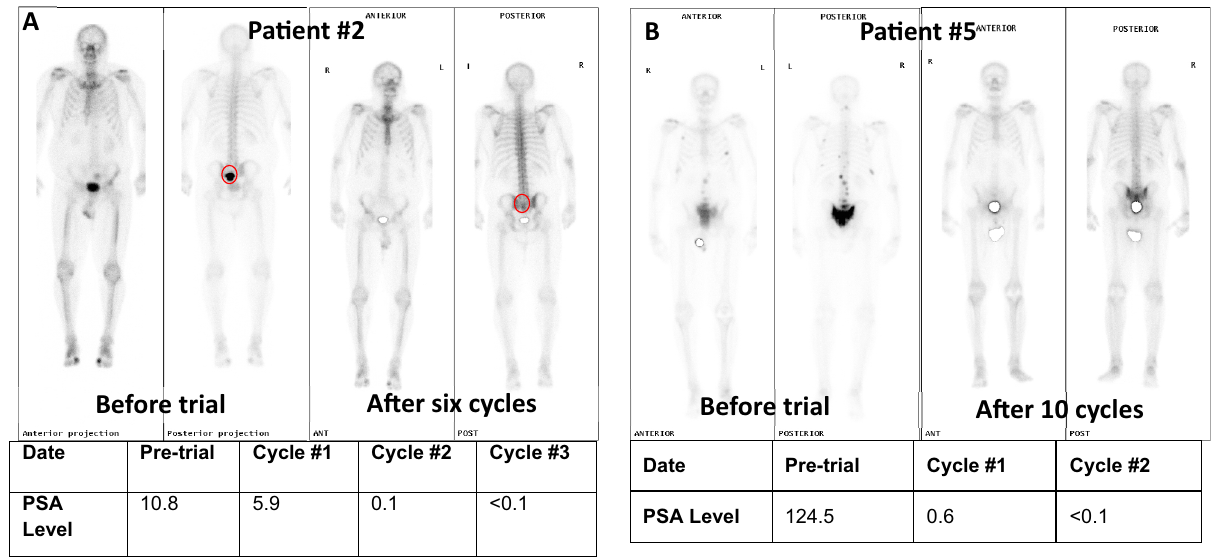
Figure 1. Bone scans and PSA kinetics in two patients with complete PSA response. In both patients, PSA became undetectable after three cycles in the combination treatment. The time of bone scan was indicated in the figure. So far, both patients have been on the study for over 3